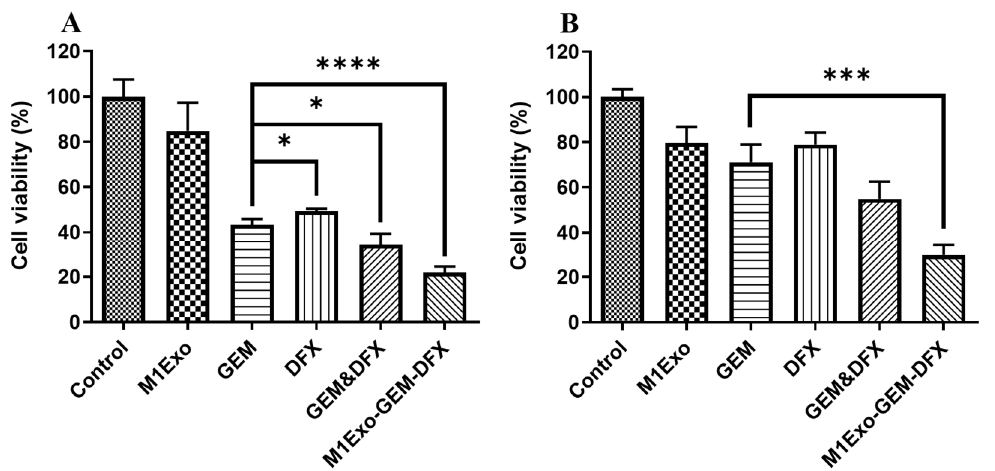
Figure 2. Cell viability study determined by the MTS assay with treatment of different drug formulations, including M1Exo, GEM, DFX, GEM&DFX, and M1Exo-GEM-DFX at a corresponding concentration of GEM and DFX in ( A ) PANC-1 cells and ( B ) PANC-1/GEM cells. (* p < 0.05, *** p < 0.001, **** p < 0.0001).